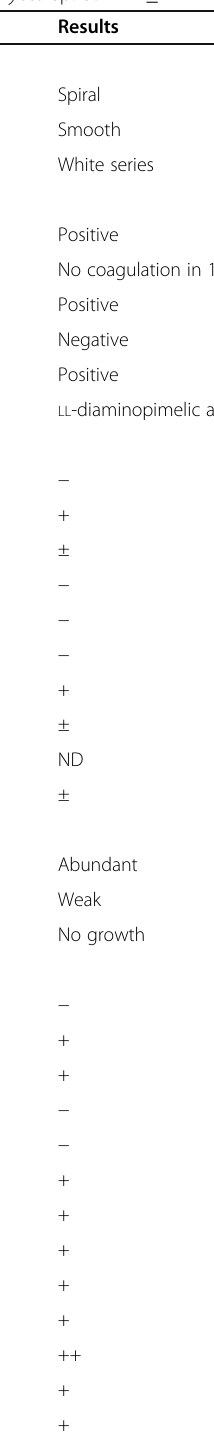
Table 2 Morphological, physiological, and biochemical properties and amino acid utilization of Streptomyces sp.